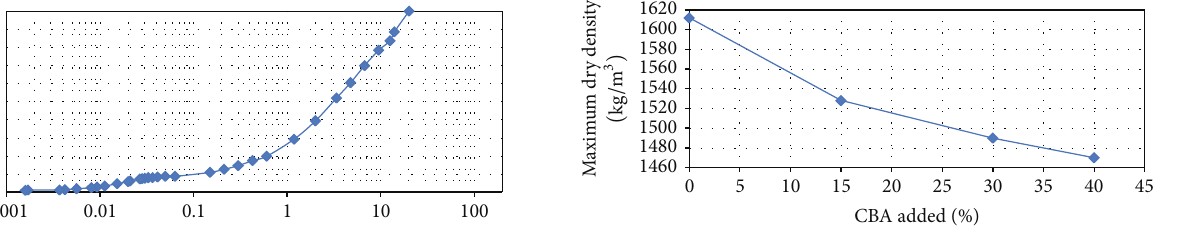
Figure 3: Particle size distribution of coal bottom ash sample.